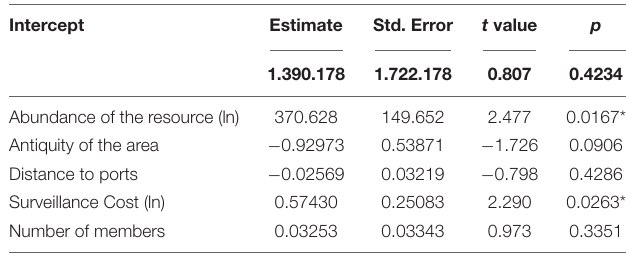
TABLE 3 | Mann-Whitney analysis to evaluate differences between the northern and southern zones.